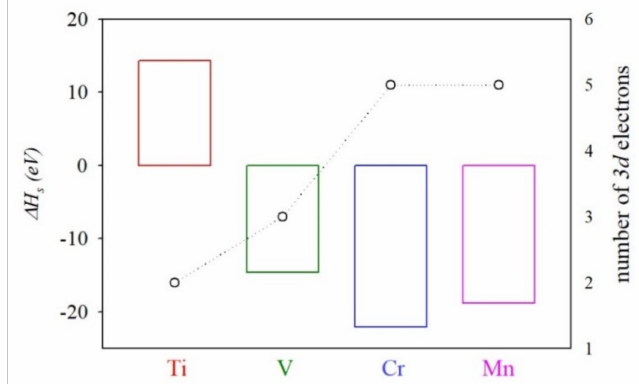
Figure 3. Calculated heat of solution ( ∆ H s ) of TM@InP compounds (TM = Ti, V, Cr, Mn) along with the number of 3d